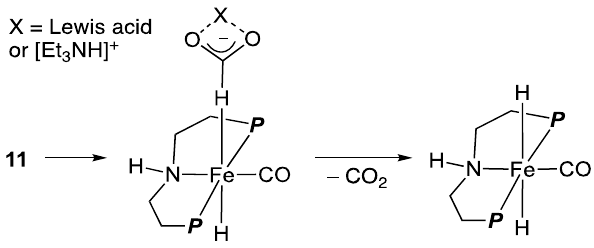
Scheme 6. Catalytic cycle proposed for the dehydrogenation of FA using 10 or 11 as catalysts.